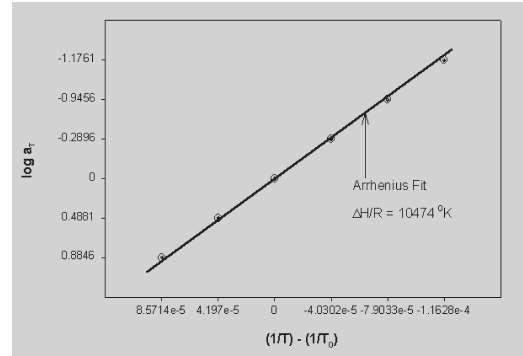
Table 2: Fit parameters from the 2-term Rouse model used for prediction of the complex viscosity as a func- tion of the frequency as dis- cussed in the text. Fig. 5: Temperature depen- dencies of the shift factors (symbols) using the Arrhe- nius equation